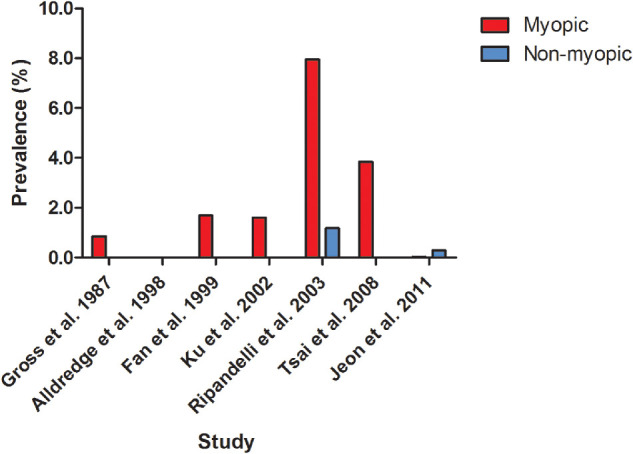
Prevalence of RD after CE in myopic patients. Horizontal axis represent different studies investigating RD rate. Two studies are case–control studies (Ripandelli et al.73 2003 and Jeon et al.72 2011), the other five studies are retrospective case series. The vertical axis represent the prevalence of RD.